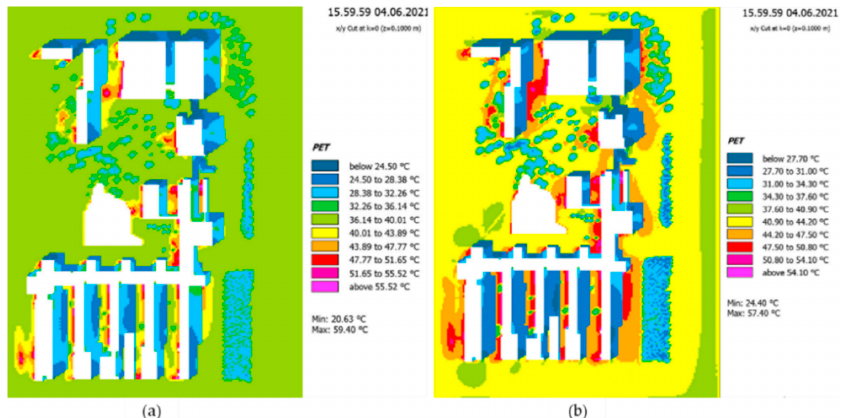
Figure 13. Visual results of PET of evaluation sample p3m2c1 on 4 June (high level of activity) ( a ), Visual results of PET of evaluation sample p4m1c2 on 4 June (low level of activity) ( b ).